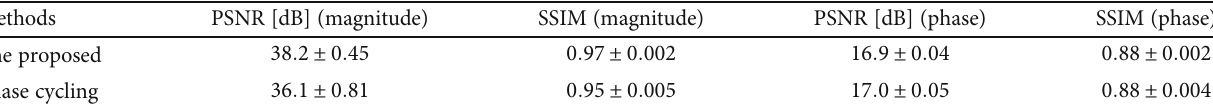
Table 1: Comparison of the magnitude results by the proposed and phase cycling methods under RSPe sampling pattern in terms of peak-to- signal noise ratio (PSNR) and structural similarity index metric (SSIM).